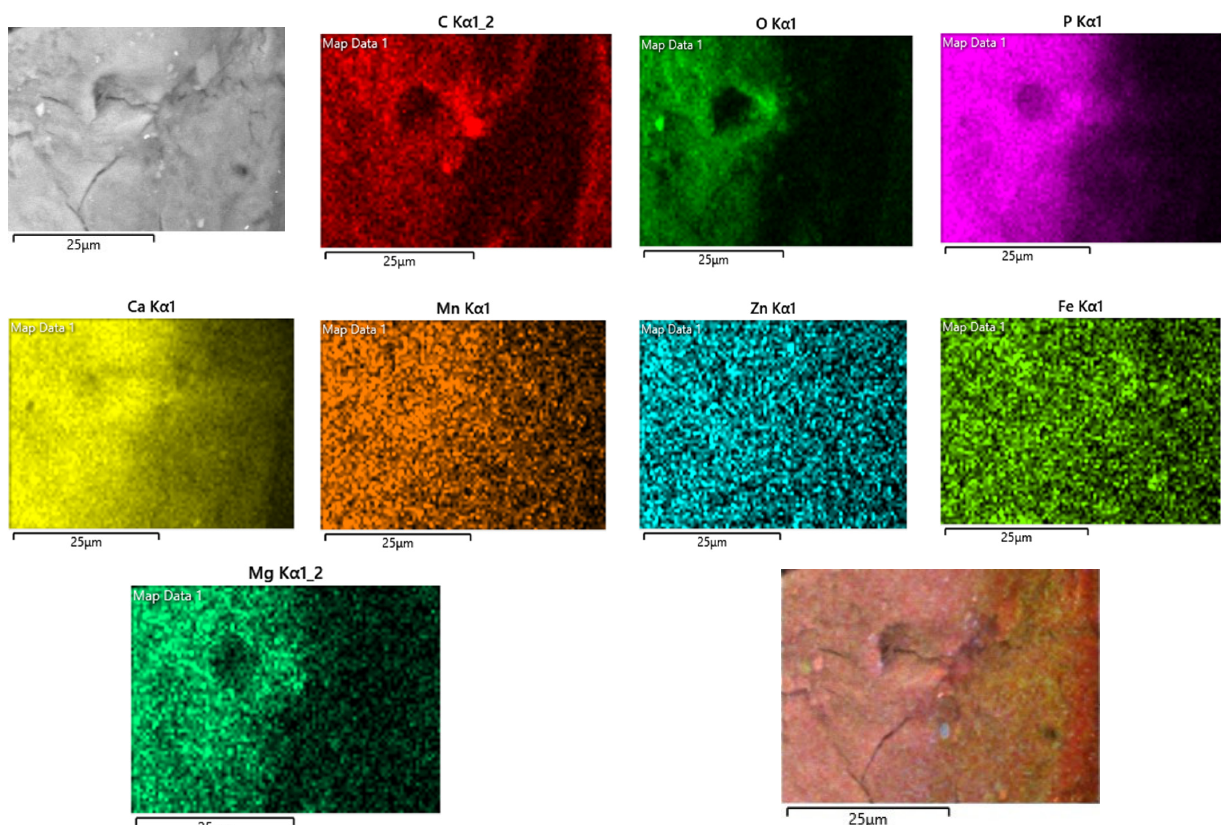
Figure 7. EDX elemental mapping of the surface of powder fish scales after 240 min of contact with AMD solution.